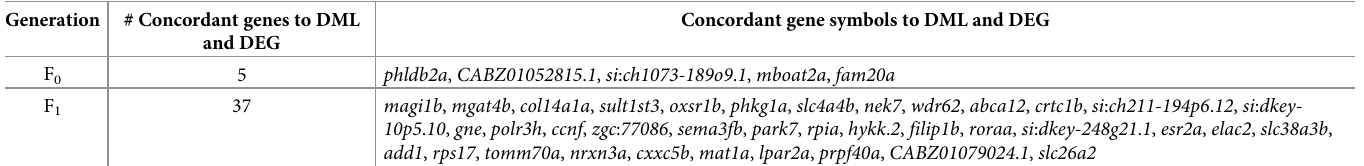
Table 2. Genes linked to differentially methylated loci (DML) concordant with differentially expressed genes (DEG) in F 0 and F 1 livers due to inclusion of high ARA in the parental (F 0 )